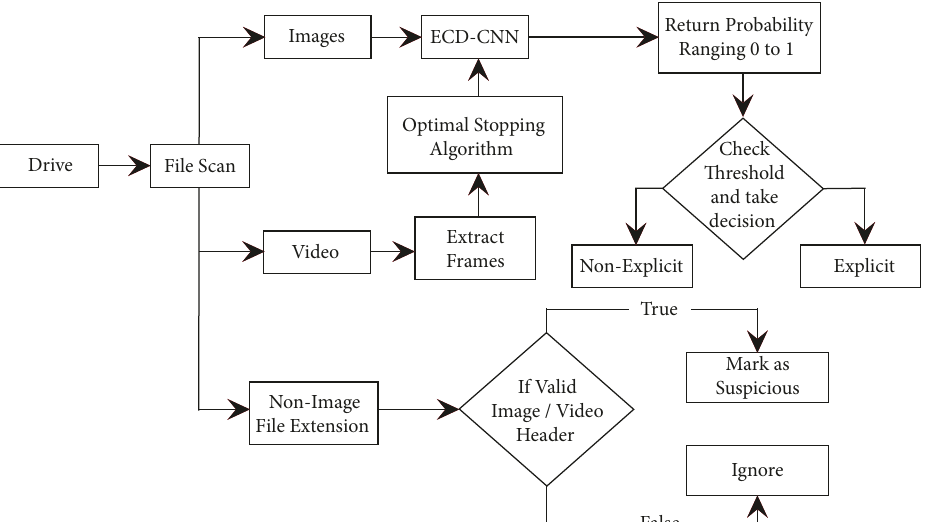
Figure 2: Block diagram of the proposed ECD system.